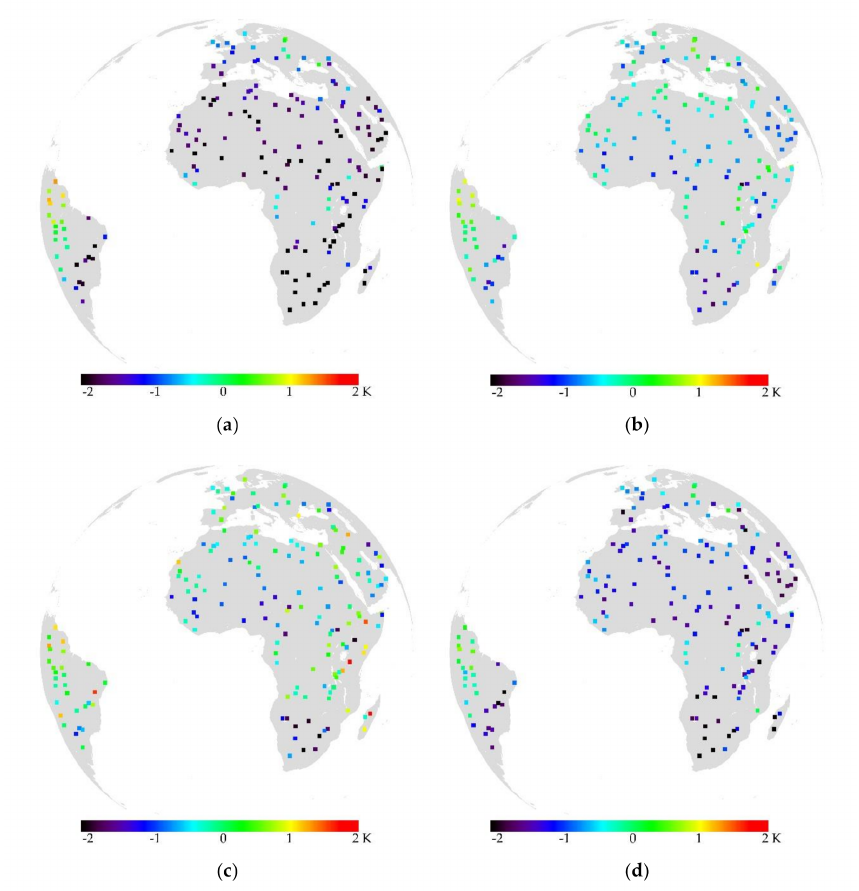
Figure 4. Bias values averaged over each BELMANIP site for the drifted time series ( a ) and the corrected time series C0, C1, and C2 ( b , c , and d ,